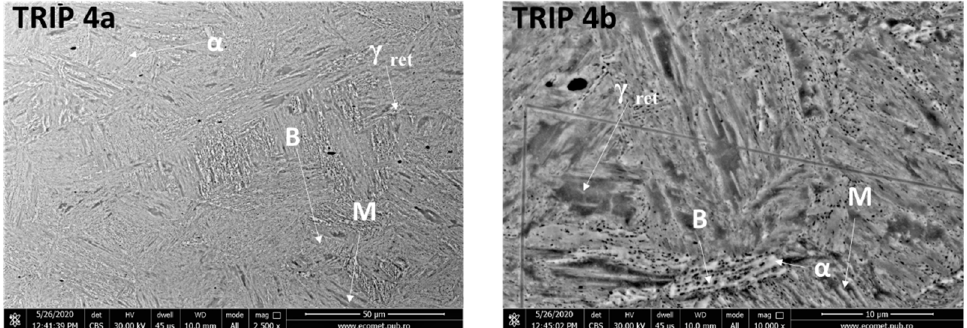
Figure 4. BSE microstructures (( a , b ) at different magnifications) of TRIP 4 steel after heat treatment.